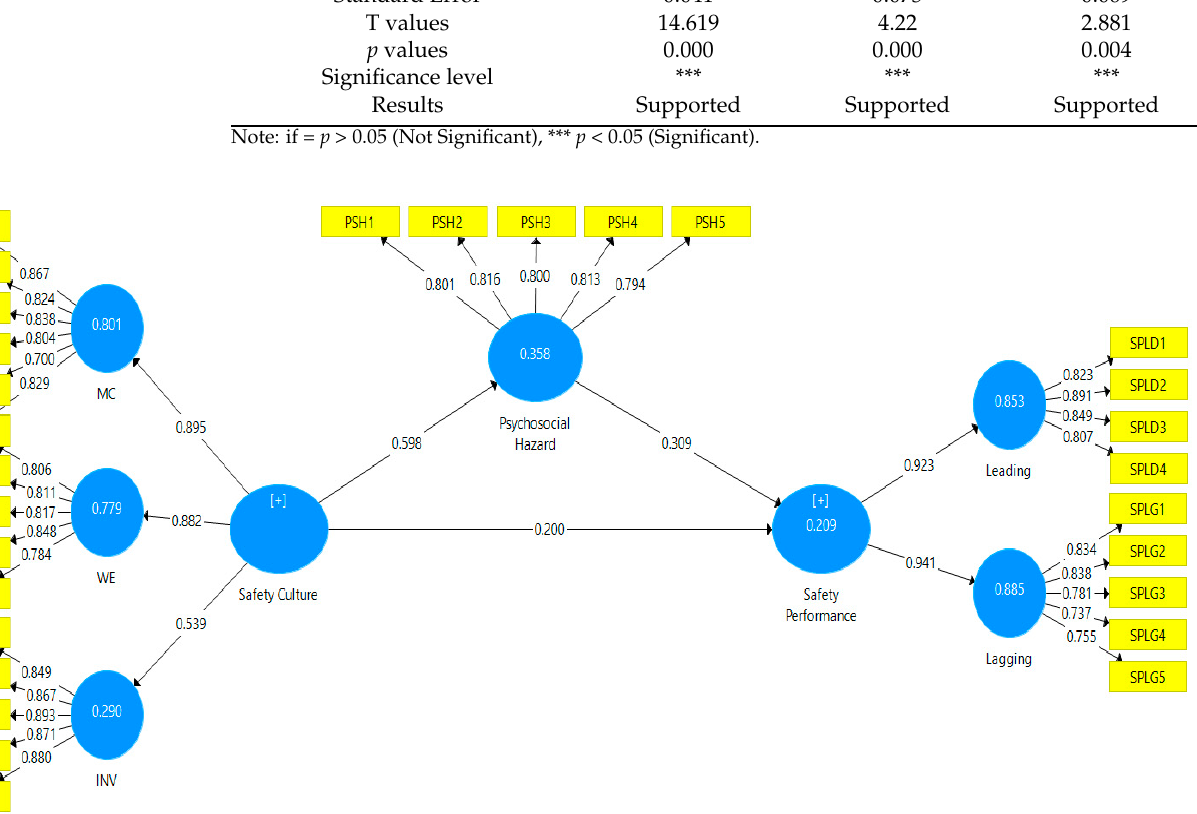
Table 8. Direct and indirect mediation results.